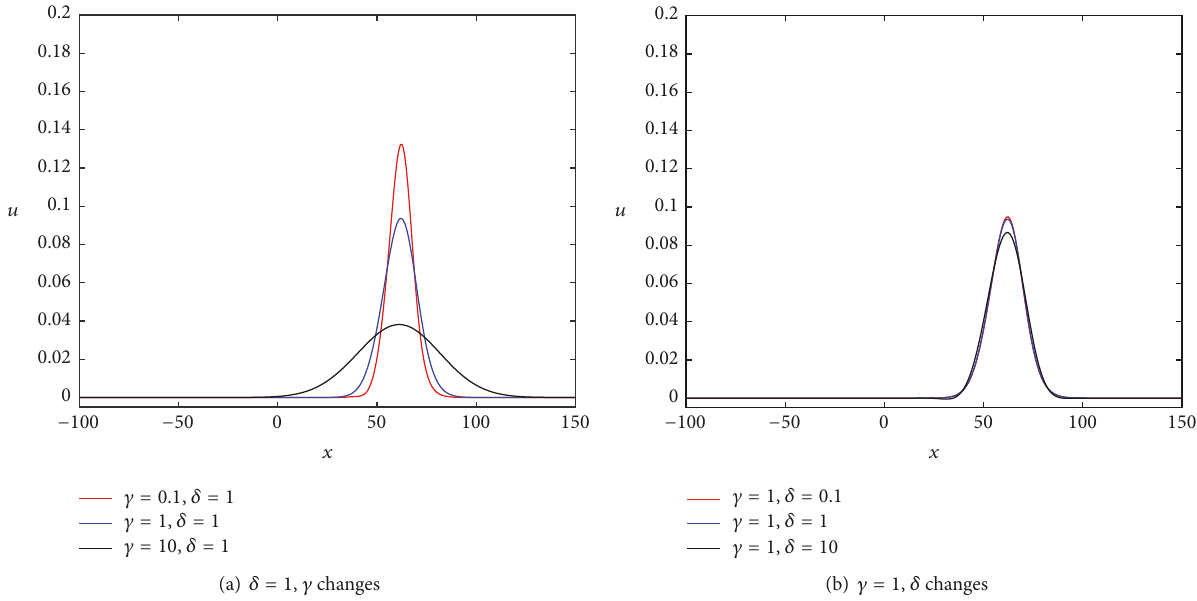
Figure 5: Example 3. The numerical solutions at the final time for different coefficients. (a) The numerical solutions of the equation with 𝛿 = 1 , 𝛾 = 0.1, 1,10 ; (b) the numerical solutions of the equation with 𝛾 = 1 , 𝛿 = 0.1, 1,10 .